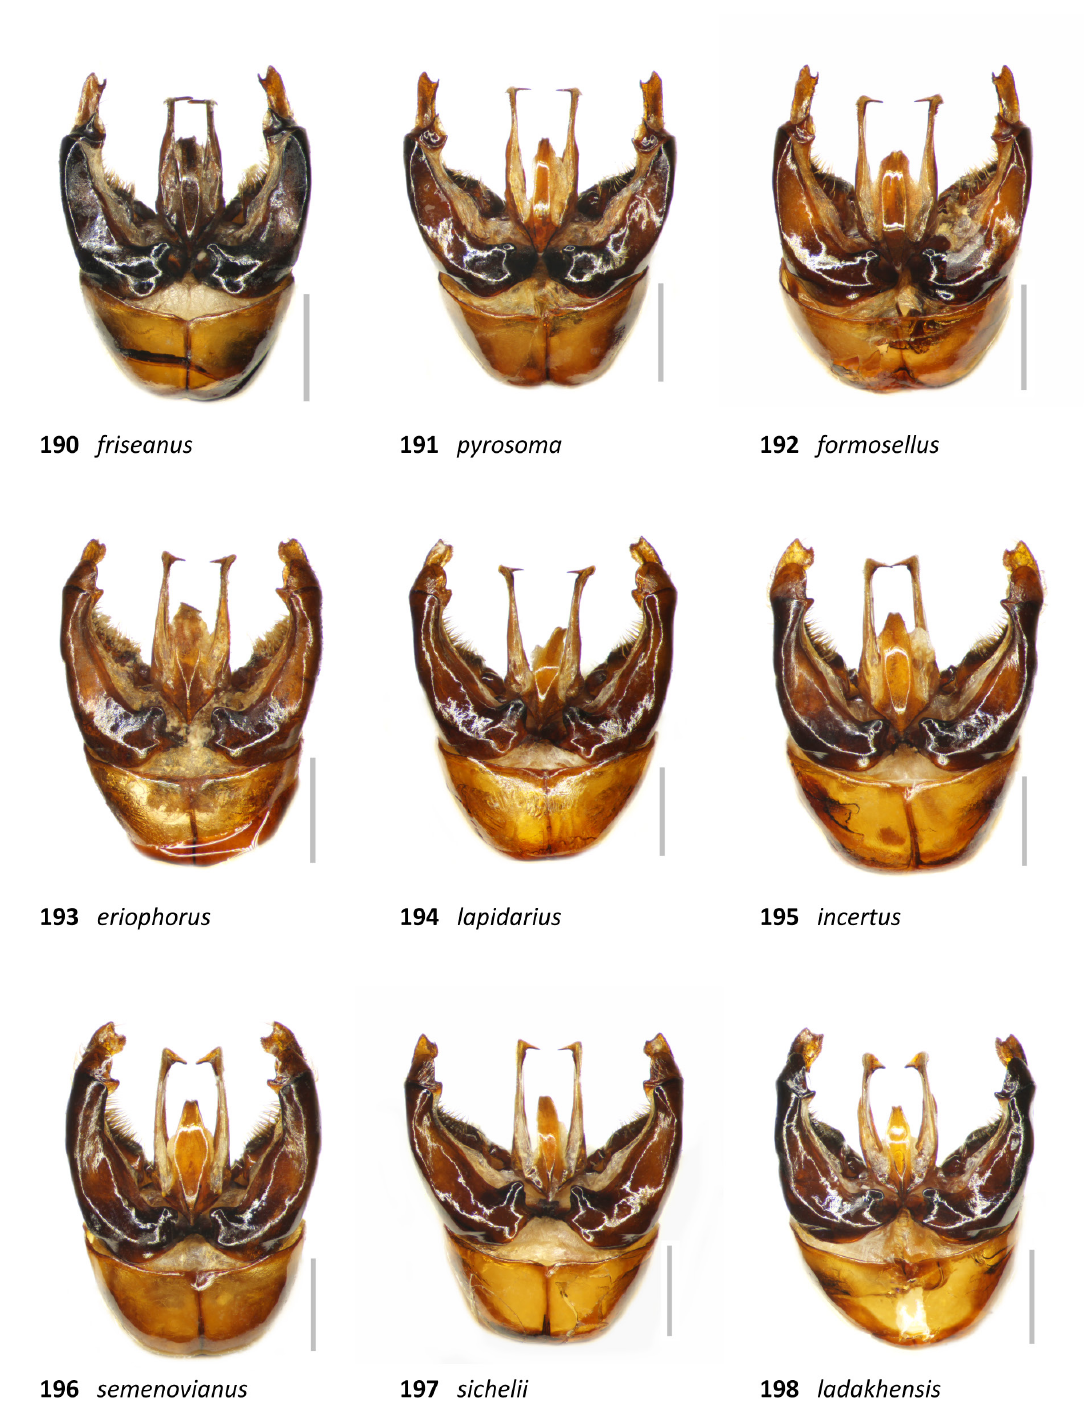
Figs 190‒198. Morphology of the male genitalia for species of the subgenus Melanobombus von Dalla Torre, 1880 from the dorsal aspect, anterior at the bottom of the image, posterior at the top. 190 . Bombus friseanus Skorikov, 1933, China-Yunnan. 191 . B pyrosoma Morawitz, 1890, China- Beijing. 192 . B. formosellus (Frison, 1934), China-Taiwan. 193 . B. eriophorus Klug, 1807, Russia- North Ossetia. 194 . B. lapidarius (Linnaeus, 1758), UK. 195 . B. incertus Morawitz, 1881, Turkey. 196 . B. semenoviaus (Skorikov, 1914), India-Kashmir. 197 . B. sichelii Radoszkowski, 1859, Austria. 198 . B. ladakhensis Richards, 1928, China-Sichuan. Scale bars = 1